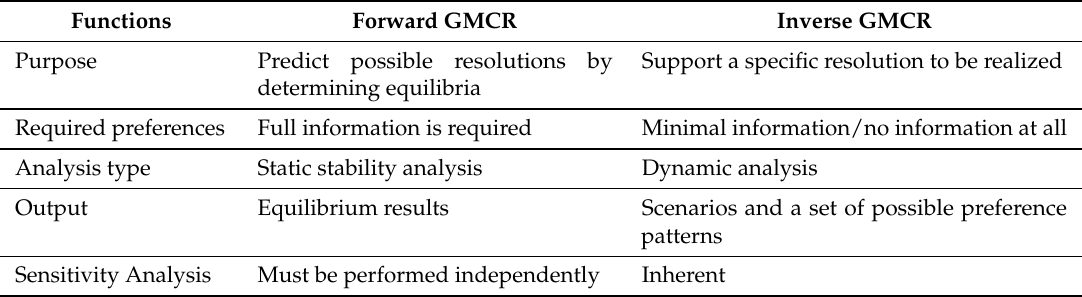
Table 2. Comparison of forward and inverse